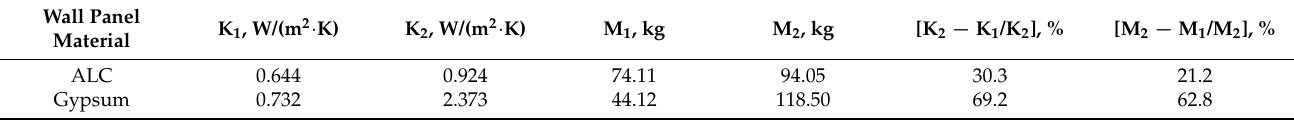
Table 3. Comparison of heat transfer coefficient and self-weight of wall